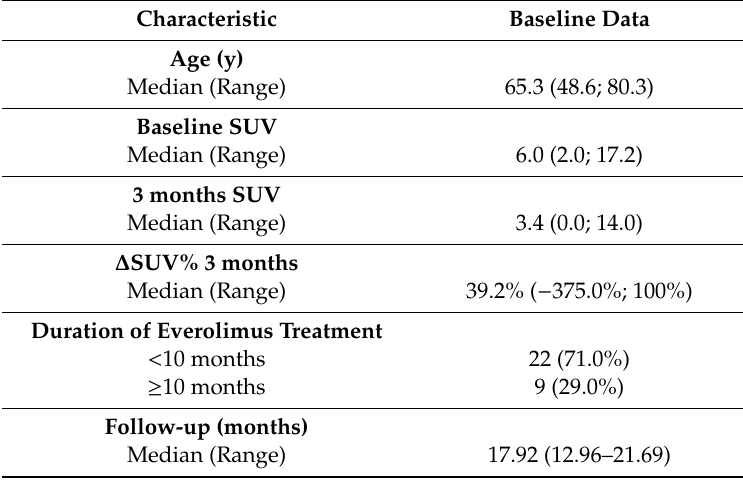
Table 1. Patient demographics and clinical characteristics of 31 patients included in the study.